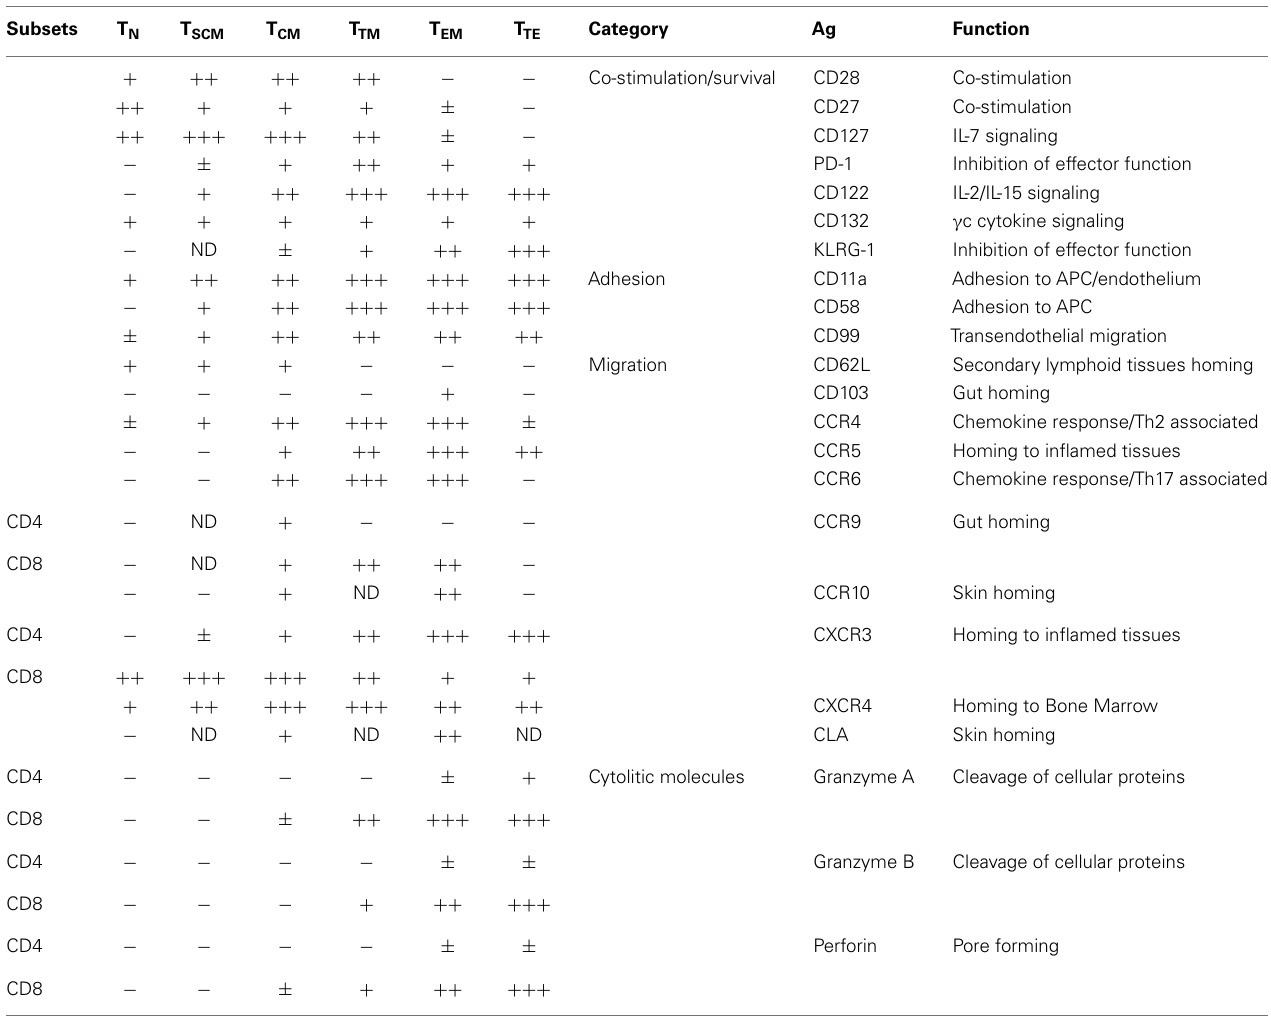
Table 1 | Expression of functional molecules by circulatingT cell